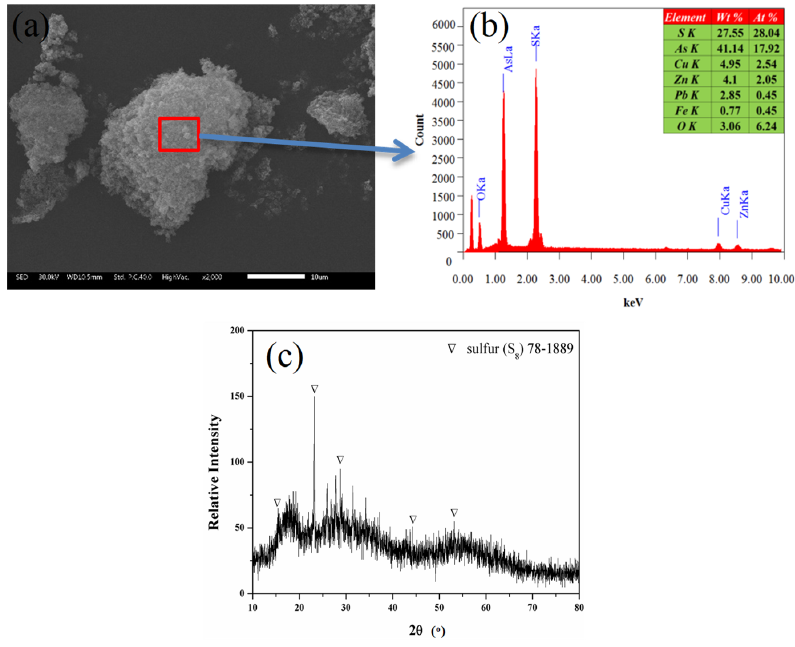
Figure 2. Characterization of the raw sample: ( a ) SEM, ( b ) EDS, and ( c ) XRD. Table 2. Main elemental composition and leaching concentration of the raw